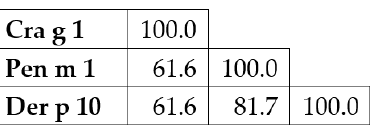
Figure 7. Percent identity matrix of tropomyosin sequences from Pacific oyster (Cra g 1), Black tiger prawn (Pen m 1) and House dust mite (Der p 10).